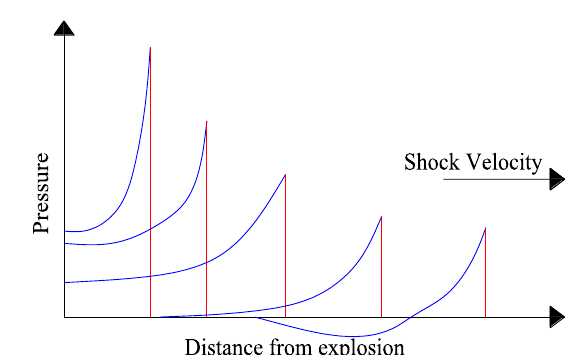
Fig. 8 Variation of pressure with distance (UFC‑3‑340‑02, 2008)